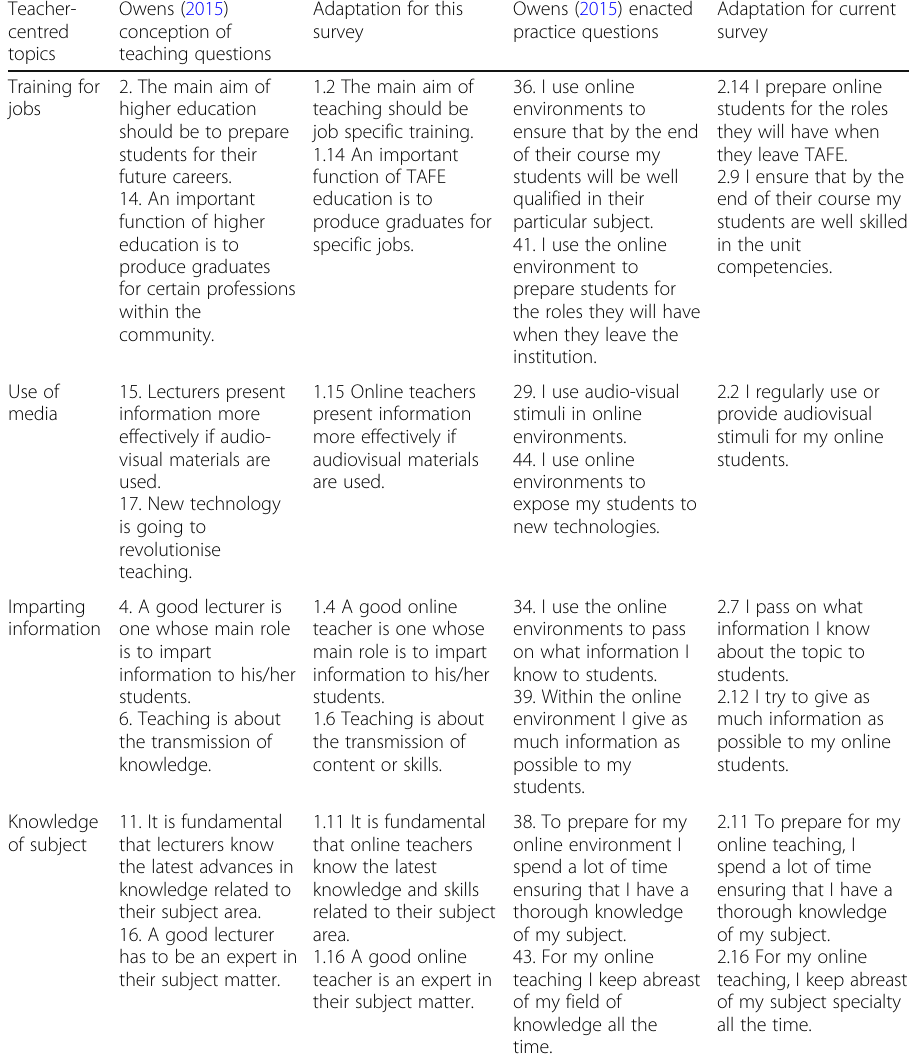
Table 10 Approach one to identifying conceptions of teaching and enacted practice. Adaptation of teacher-centred questions from Owens (2015)